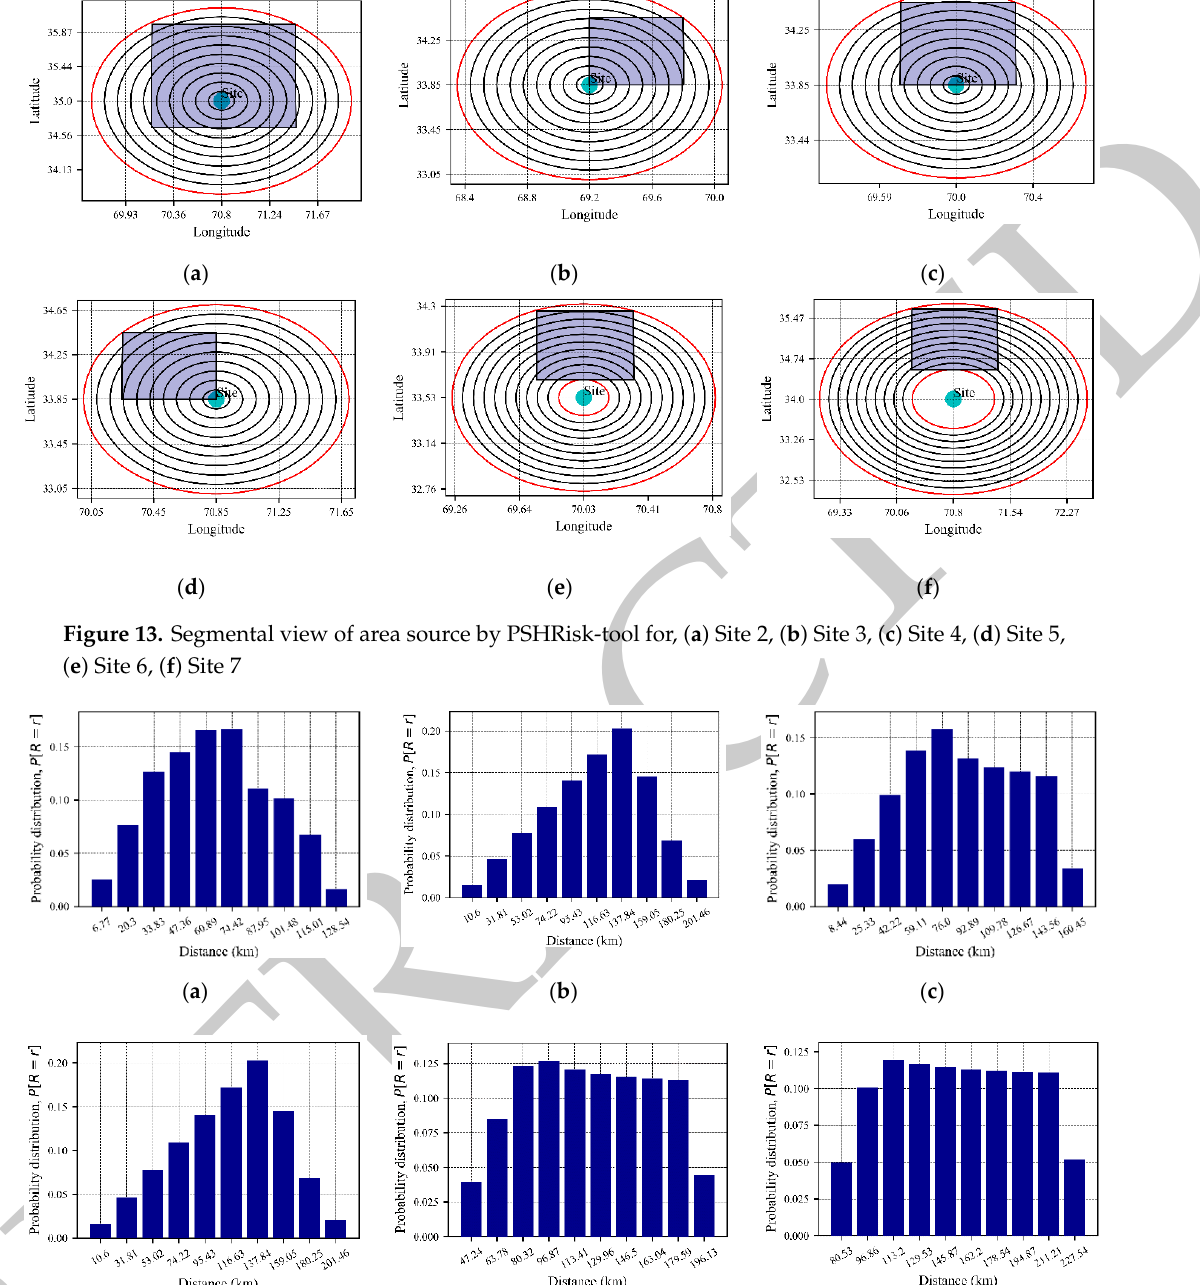
Figure 12. ( a ) Segmental view of area source, ( b ) Probability density function of distance, ( c ) Illustration of probability density function for magnitude for a source with a truncated Gutenberg– Richter distribution, ( d ) Probabilistic seismic hazard curve, respectively for Site 1 by PSHRisk-tool.